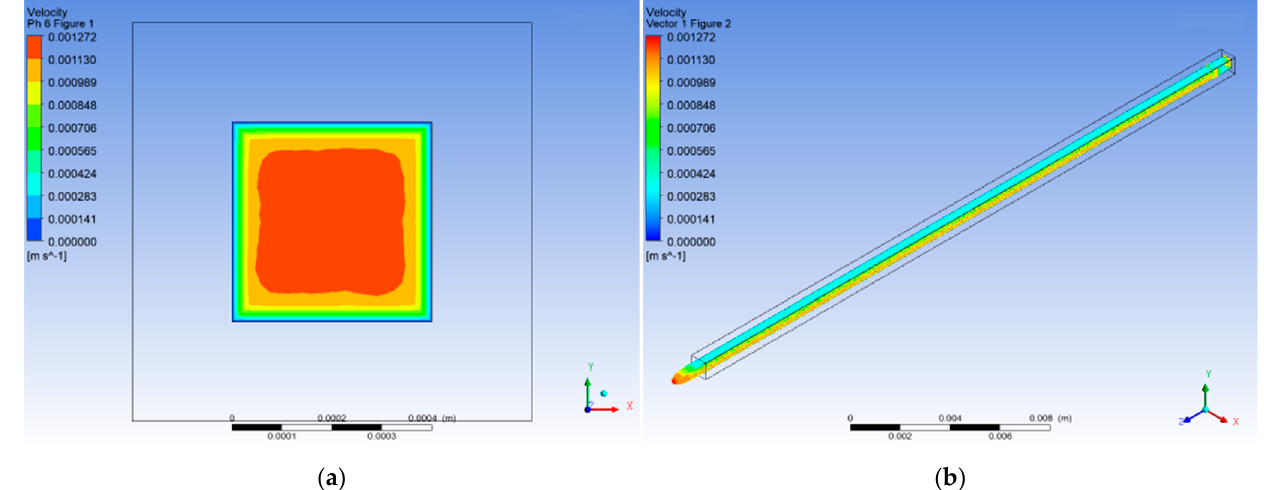
Figure 11. CFD numerical analysis results (pH 6): ( a ) contour; ( b ) vector.